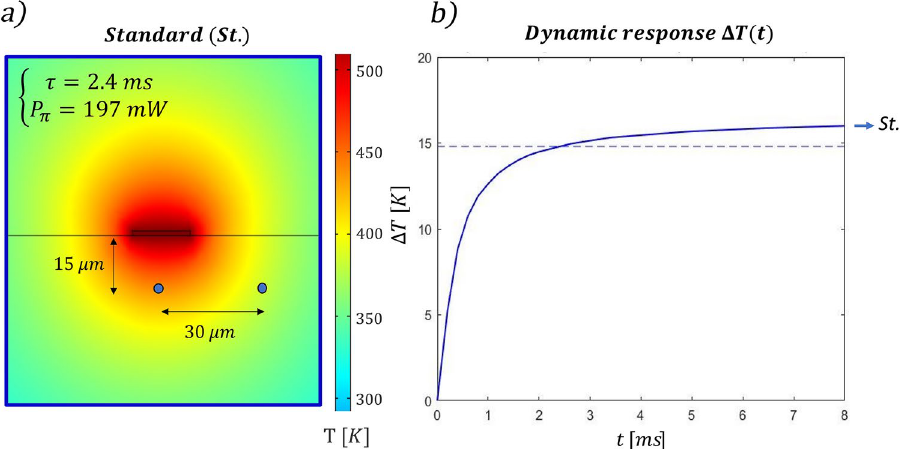
Figure 3. ( a ) Temperature distribution in the device cross-section when 250 mW are applied to the resistor. ( b ) Dynamic response of the device under the same dissipated power, the 90% of the steady state condition is reached after about 2.4